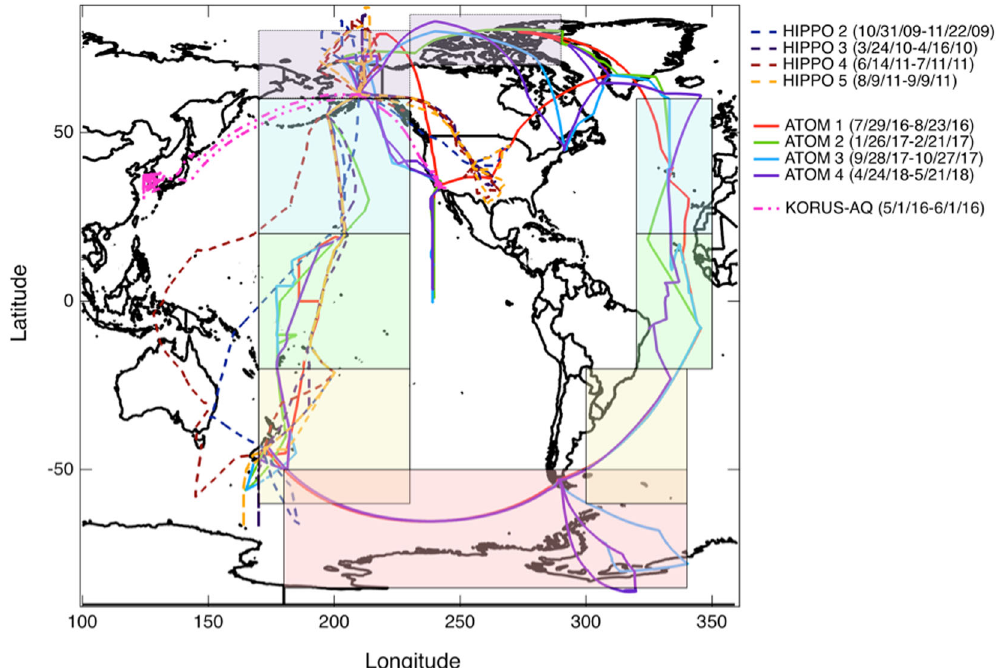
Fig. 1 Flight paths of the research aircraft for the HIPPO, KORUS-AQ, and ATom campaigns. Observations from research fl ights spanning four seasons and 9 years are used in this analysis. The shaded boxes show boxes used in the calculation of average regional values given in Table 1 and vertical pro fi les (purple — 60°N – 80°N for Paci fi c and 70°N – 85°N for Atlantic, blue — 20°N – 60°N, green — 20°S – 20°N, yellow — 60° S – 20°S, red — Southern Ocean) shown in Figs 6,